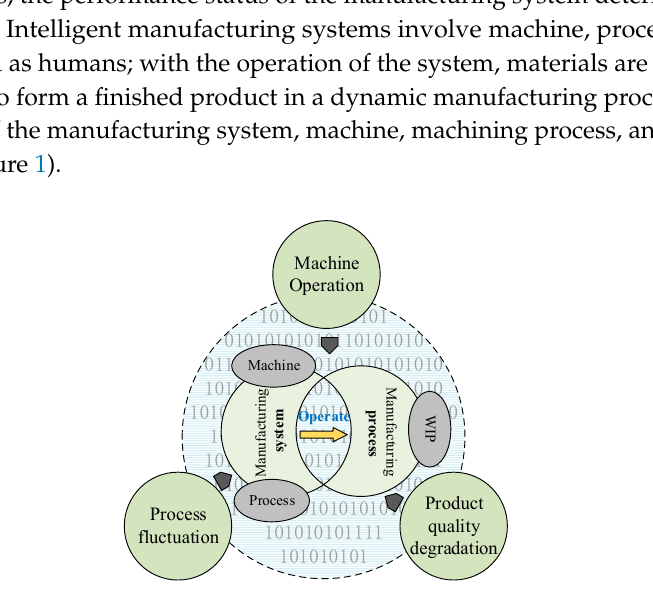
Figure 1. Composition and operation of the manufacturing system.